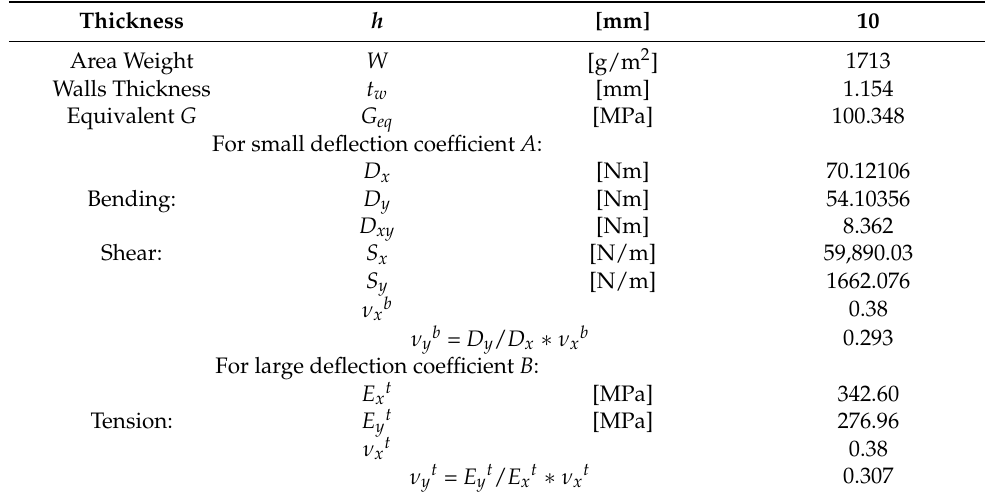
Table 1. The elastic constants of this multiwall